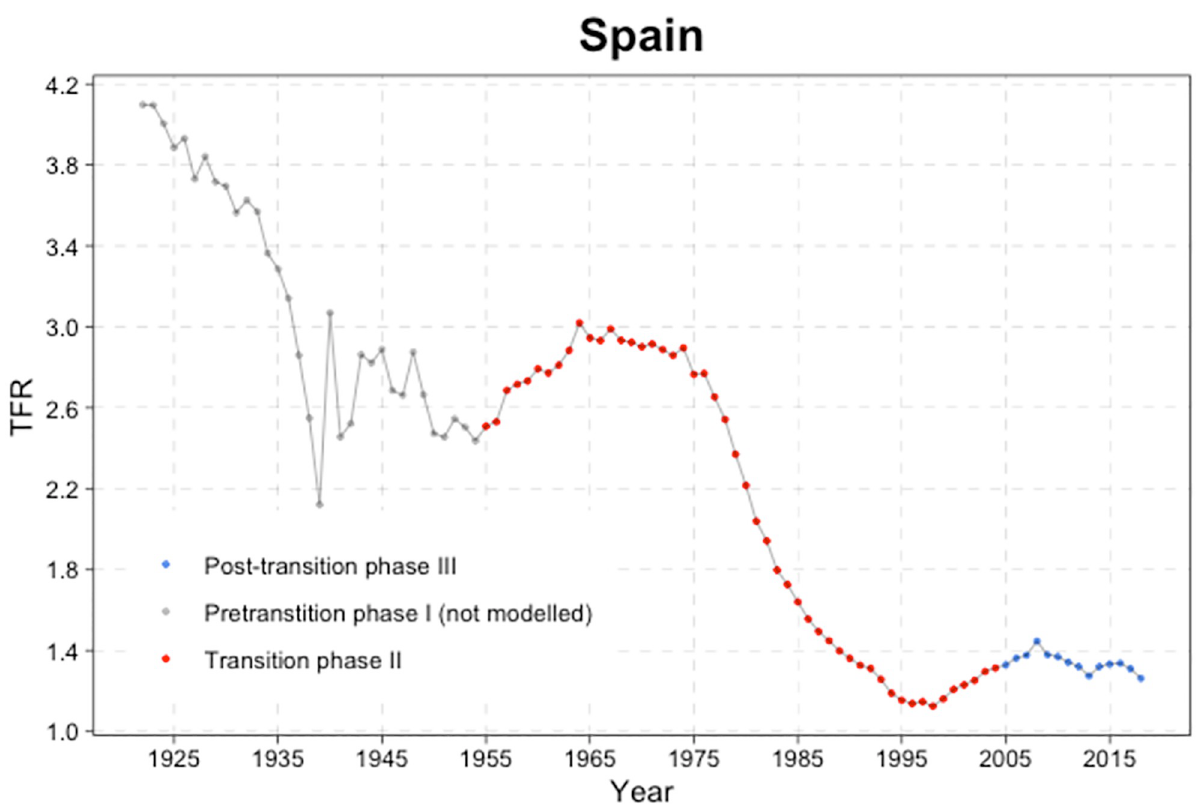
Fig 2. Number of births in Spain from 1960 to 2020. Source: Data from the Spanish Statistical Office (INE).